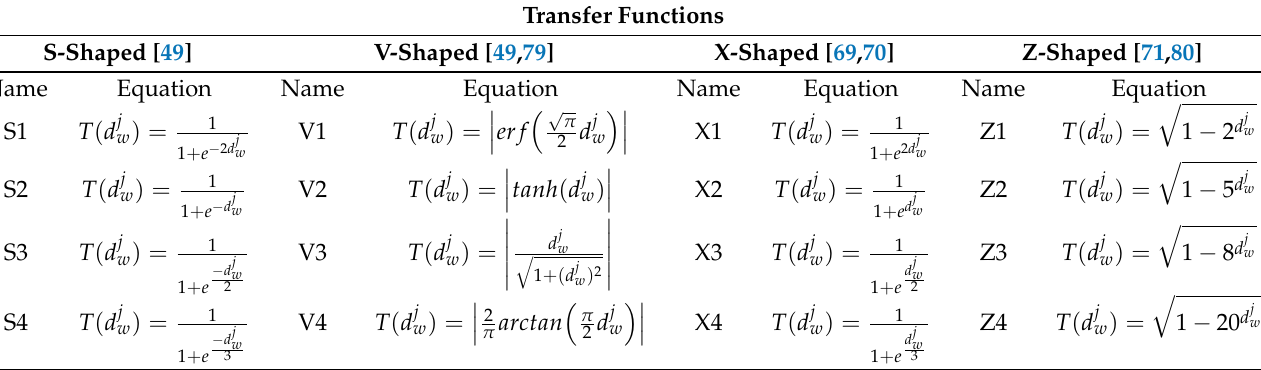
Table 1. Transfer